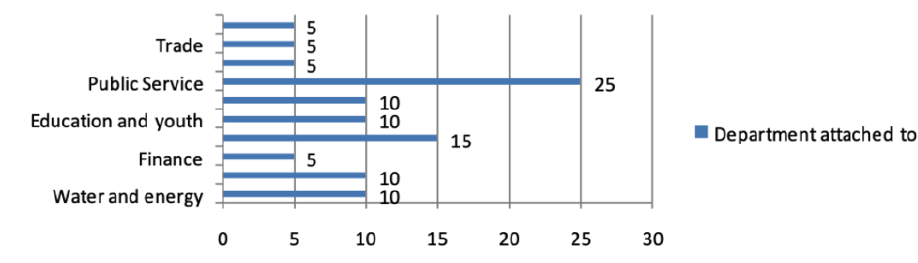
Figure 2: Department attached